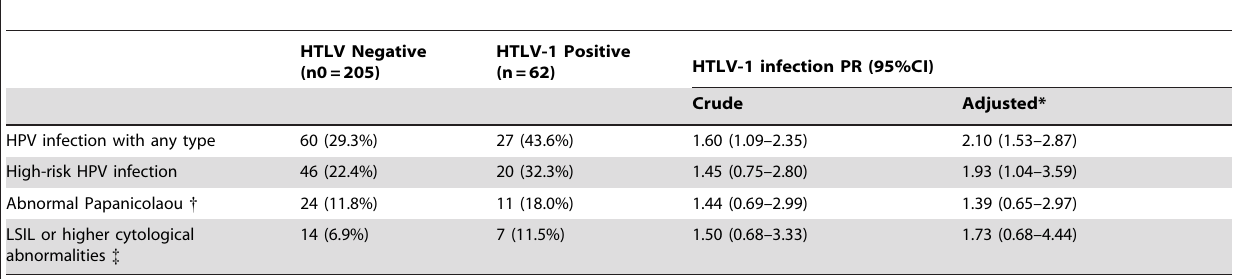
Table 3. Association between HTLV-1 infection and HPV infection and cytological abnormalities in women from the Shipibo- Konibo ethnic group.